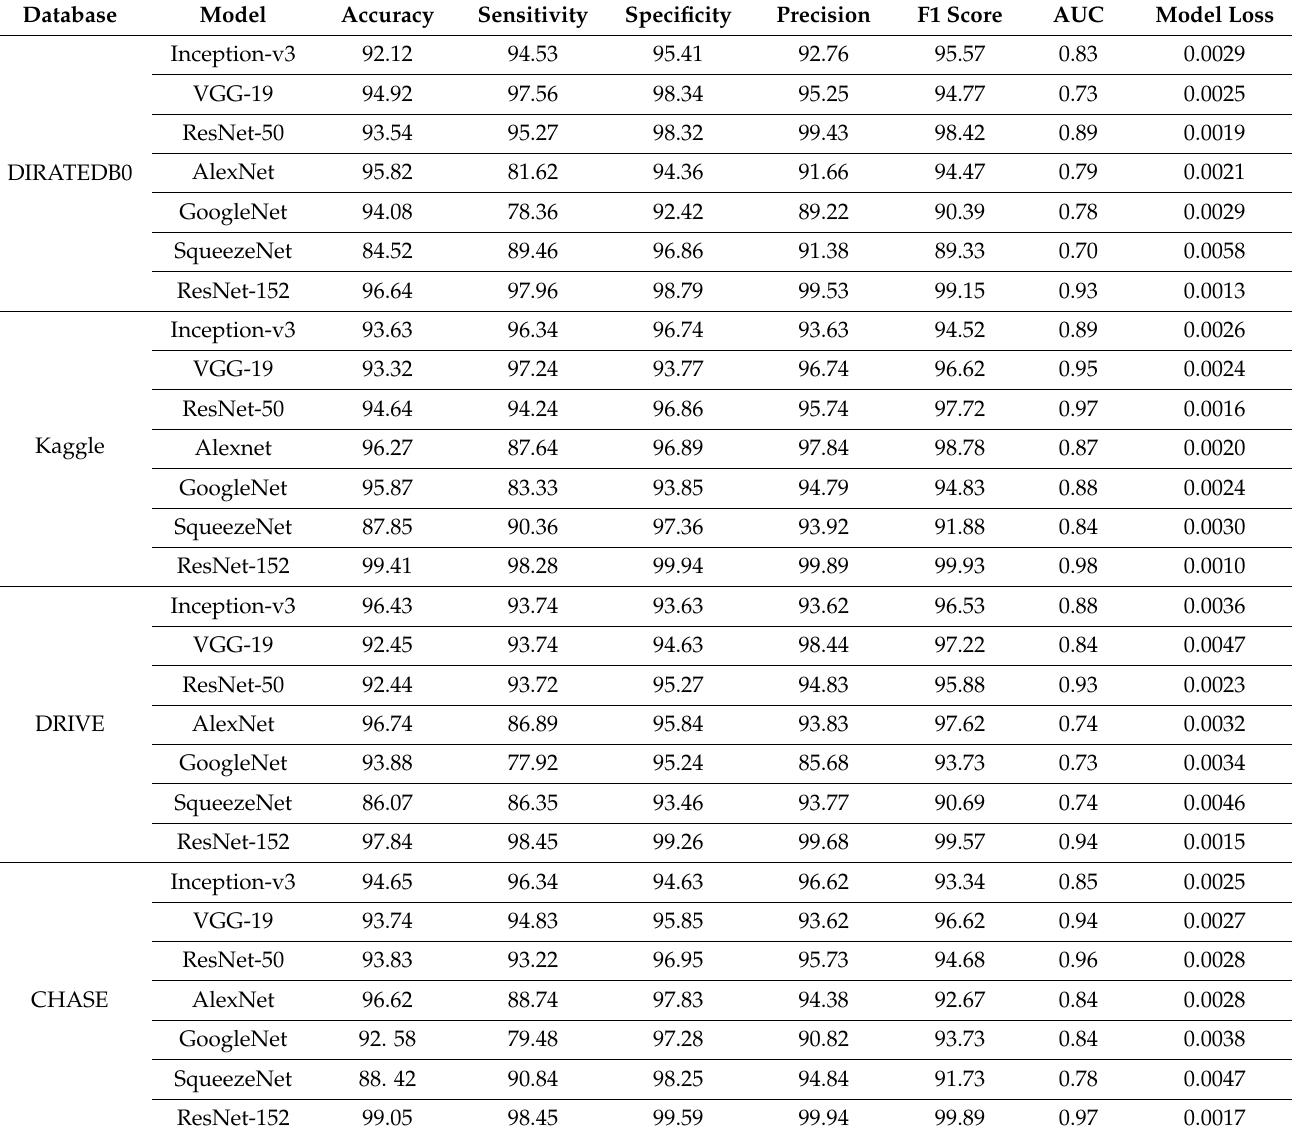
Table 5. Performance comparison of different CNN models with proposed activation function on different